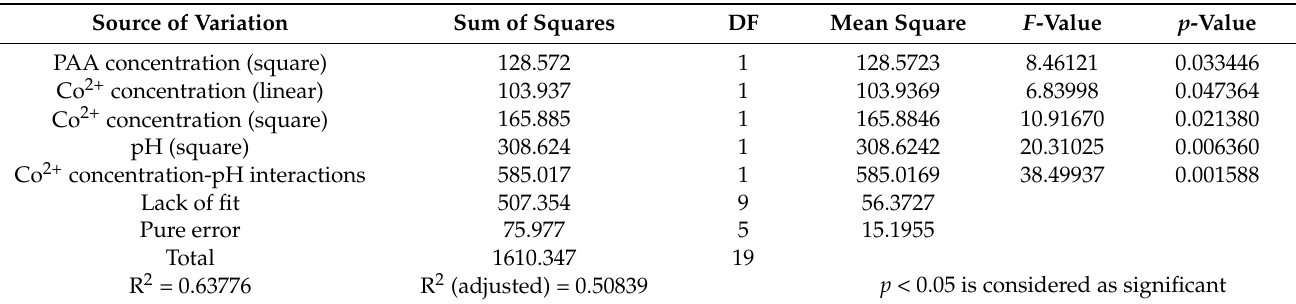
Table 4. ANOVA results for UV-326 removal efficiency from